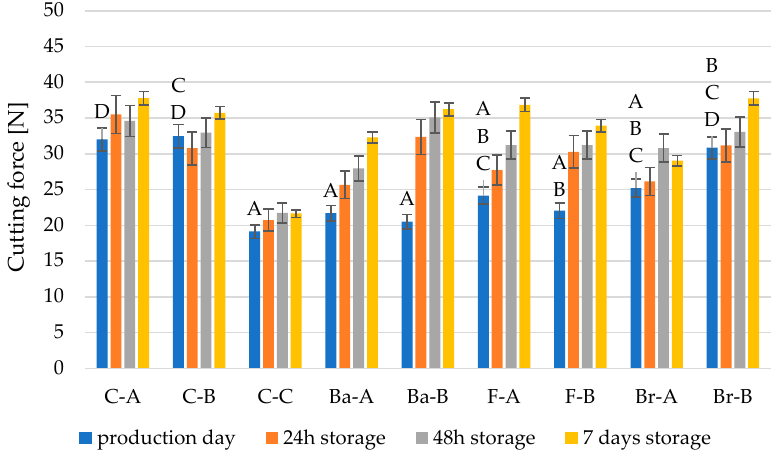
Figure 2. Texture results of chicken breast fillet samples expressed by cutting force. Code designations as in Table 1. Different letters A, B, C . . . in columns show the statistical difference ( p < 0.05) related to the impact of the heating